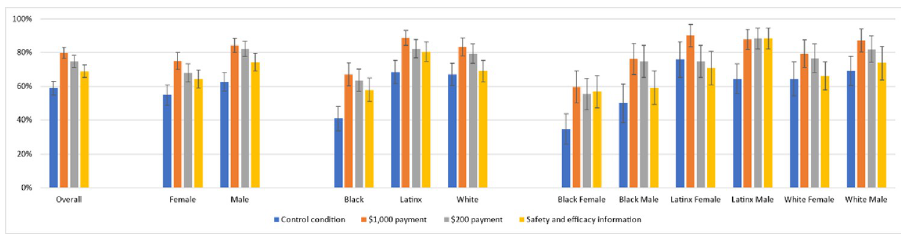
Fig 1. The percentage wanting the COVID-19 vaccine by race/ethnicity and